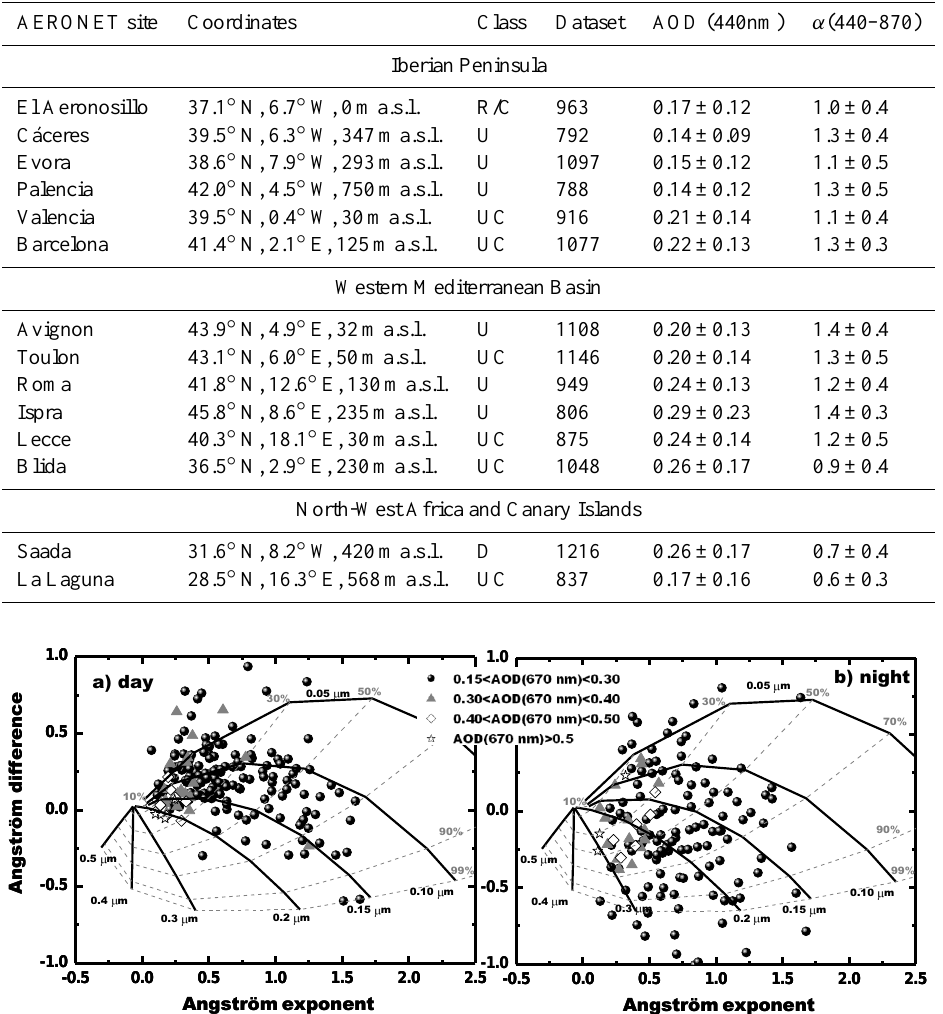
Table 2. Mean values of aerosol optical depths at 440 nm and α (440–870nm) obtained during the period 2007–2010 at 14 AERONET stations. A brief description of each AERONET site is also included. The stations are defined as Desert areas (D), Remote (R), Urban sites (U) and Costal areas (C).